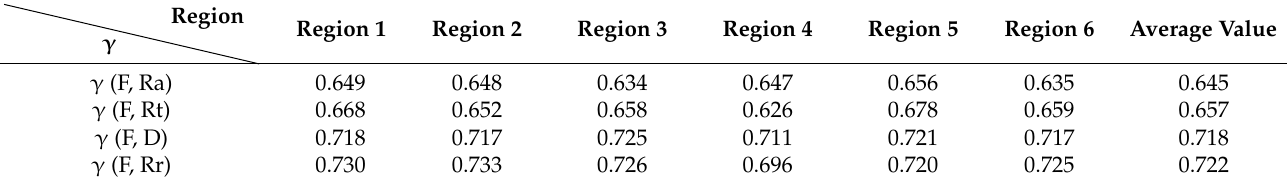
Table 3. Gray correlation